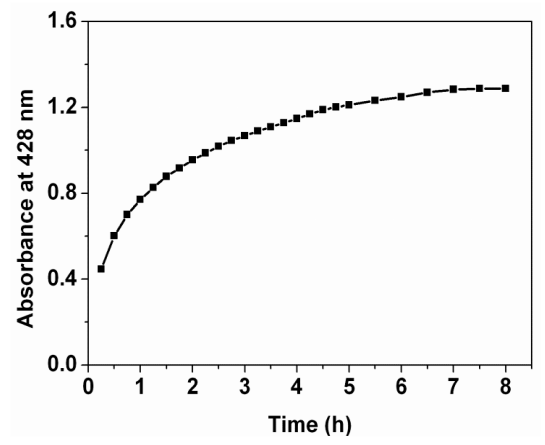
Figure 3. UV-Vis kinetic study of Ag nanoparticles formation.